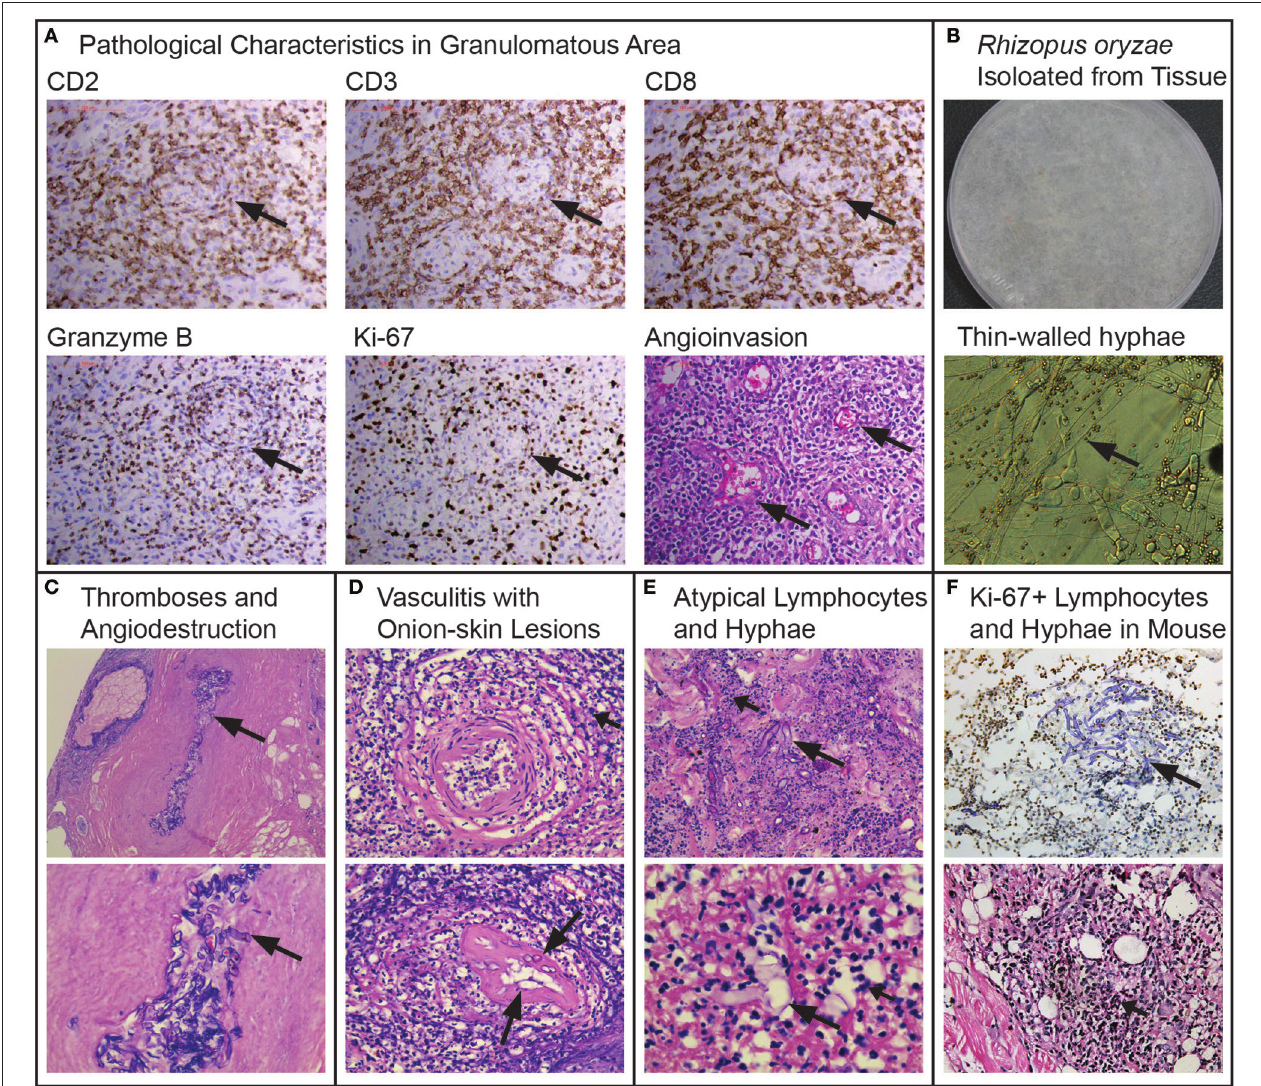
FIGURE 2 | “ Rhizopus arrhizus associated lethal midline granuloma/rhino-orbital cerebral mycosis.” Pathologic characteristics of the midline face destruction patient, the fungus and hyperplasia replicated in the mouse models. (A) Shows the pathological characteristics in the granulomatous area with immunohistochemically positive staining of CD2, CD3, CD8, GranzymeB, and Ki-67 from granulomatous tissues (Envision method, original magnification × 400) and angioinvasion (H&E, original magnification × 400). (B) Rhizopus arrhizus (PUTH 20111112) isolated from tissue: lanose appearance with grayish color 5 days growth on PDA and thin-walled hyphae (arrows) and conidia (lactophenol cotton blue staining, original magnification × 400). (C) Fungal thromboses (long arrow), angiodestruction and angiocentric coagulative necrosis (short arrows, H&E, original magnification × 200 and × 400, respectively). (D) Atypical cells (short arrows) and hyphae (long arrows) among Onion-skin lesions (H&E staining, original magnification × 400). (E) Atypical lymphoid cells (short arrows) and hyphae (long arrows) (H&E staining, original magnification × 400 and × 1,000, respectively). (F) Ki-67 positive cells and hyphae with immunochemical staining in mouse infected by Rhizopus arrhizus (PUTH 20111112) (Envision method, original magnification × 400) hyperplasia with H&E staining (original magnification ×